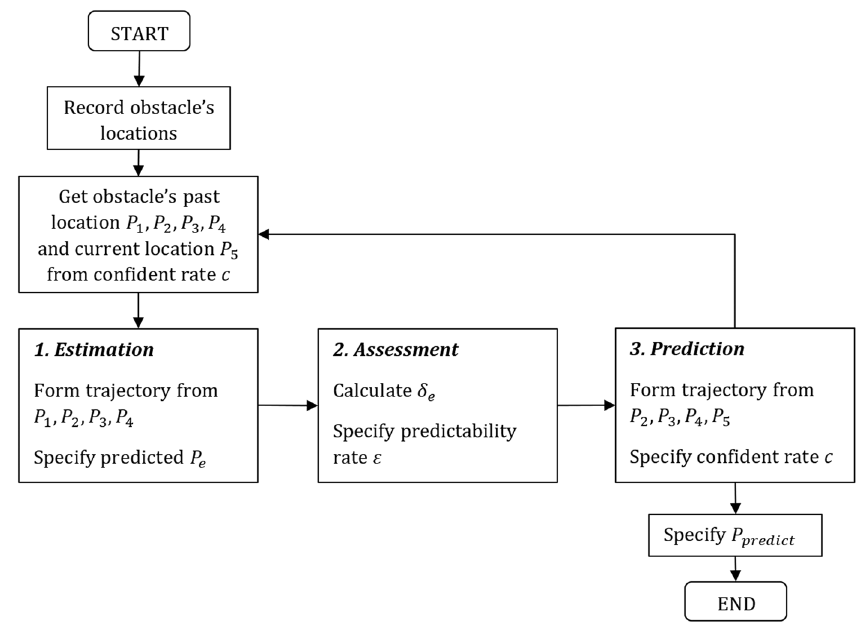
Figure 6: Prediction process fl